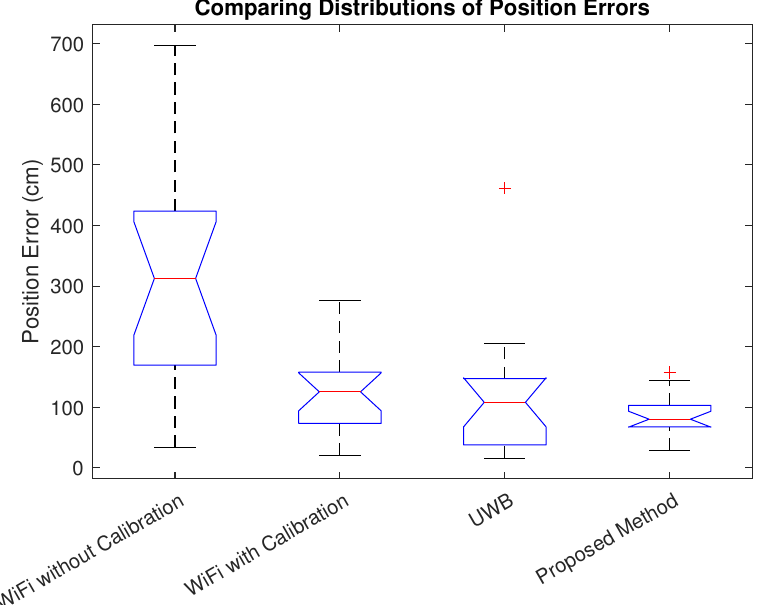
Figure 21. Box plots showing positioning errors using different methods. The proposed hybrid method provides the best accuracy with the smallest error variance.